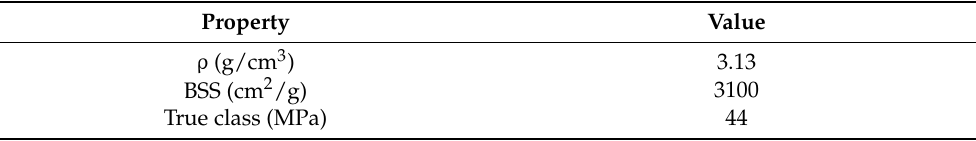
Table 2. Physical and mechanical properties of cement.